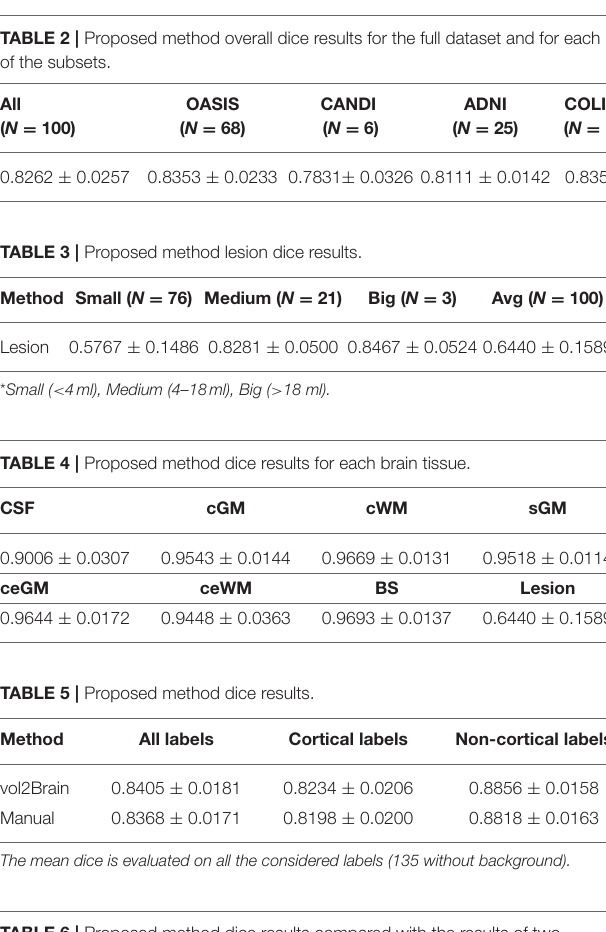
TABLE 6 | Proposed method dice results compared with the results of two versions of JLF